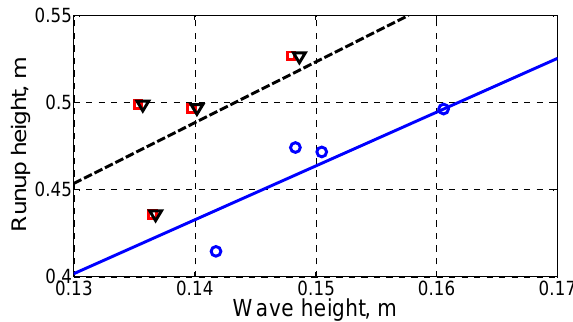
Fig. 8. Mean run-up and wave height in the wake, calculated from the original data (red squares) and reconstructed from Rayleigh (blue circles) and Weibull (black triangles) distributions; blue solid and black dashed lines corresponds to the regression curve fitted the heights calculated from the Rayleigh and Weibull distributions respectively.